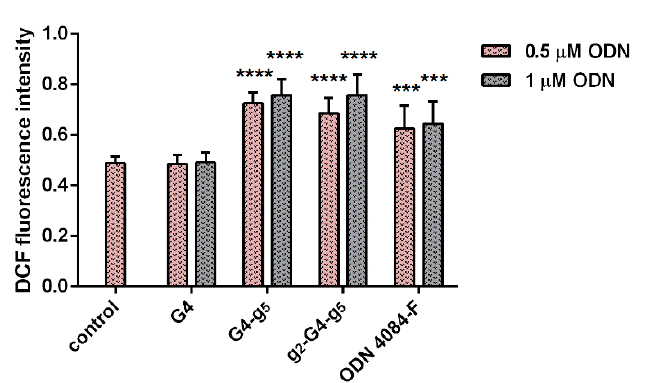
Figure 5. ODNs with phosphorothioate oligoguanosines attached to the ends of human telomeric repeats trigger formation of intracellular oxidants. H 2 DCF-DA-stained PMNLs (1 × 10 6 /mL) were cultured for 1 h at 37 °C in 5% CO 2 with no additives (control probe) or in the presence of ODNs at indicated concentrations. Then green fluorescence was measured by flow cytometry. Values represent the means ± SEM of DCF (DCF (2 ′ ,7 ′ -dichlorofluorescein) fluorescence intensities (arbitrary units) (n = 6). *** p < 0.05, **** p < 0.001 compared to the control probe without ODN, as indicated by two-way ANOVA followed by Sidak’s multiple comparison test.